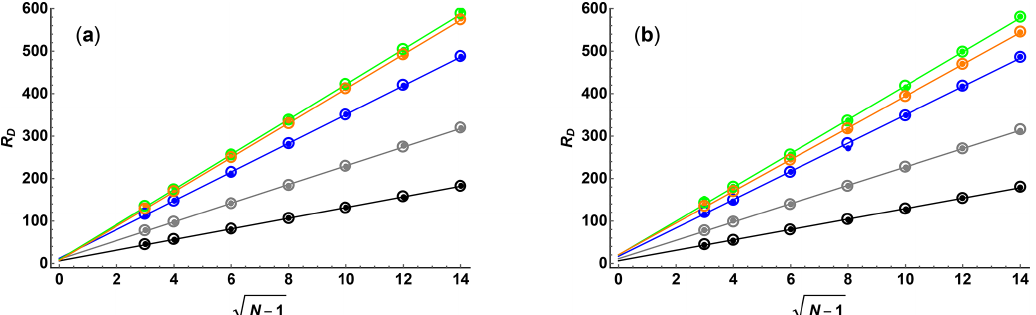
√ ( N − 1), where N is the number of gradient values used, for (a) linear and (b) quadratic Figure 1. Diffusion resolution R D as a function of sampling in the gradient domain, determined by Monte Carlo simulation (small filled circles) and Cramér–Rao least bounds analysis (open circles), for SNR = 100 and maximum Stejskal–Tanner exponents (cid:15) max of 0.25 (black), 0.5 (grey), 1 (blue), 2 (green), and 3 (orange). Solid lines show the results of linear regression of the Cramér–Rao data.